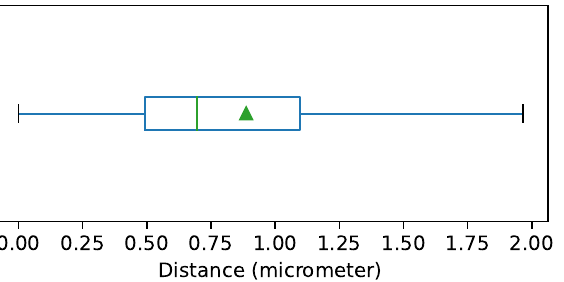
Figure 4. Boxplot showing the distribution of the average distances between control points after image registration. Each box is drawn from the first to the third quartile. The horizontal line represents the median value, and the triangle represents the mean. The whiskers indicate the minimum and maximum value of the distribution.